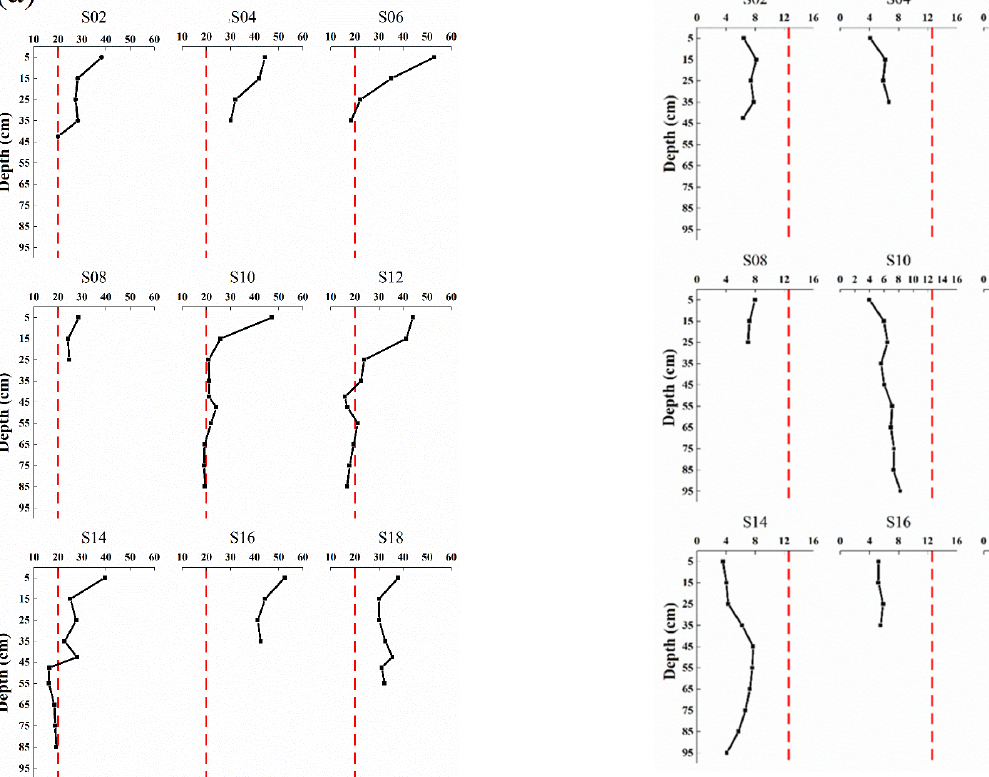
Figure 3. The vertical distributions of Hg ( a ) and As ( b ) in the soils (S02, S04, S06, S08, S10, S12, S14, S16, and S18 were from 3060 to 3450 m of SDL, respectively).